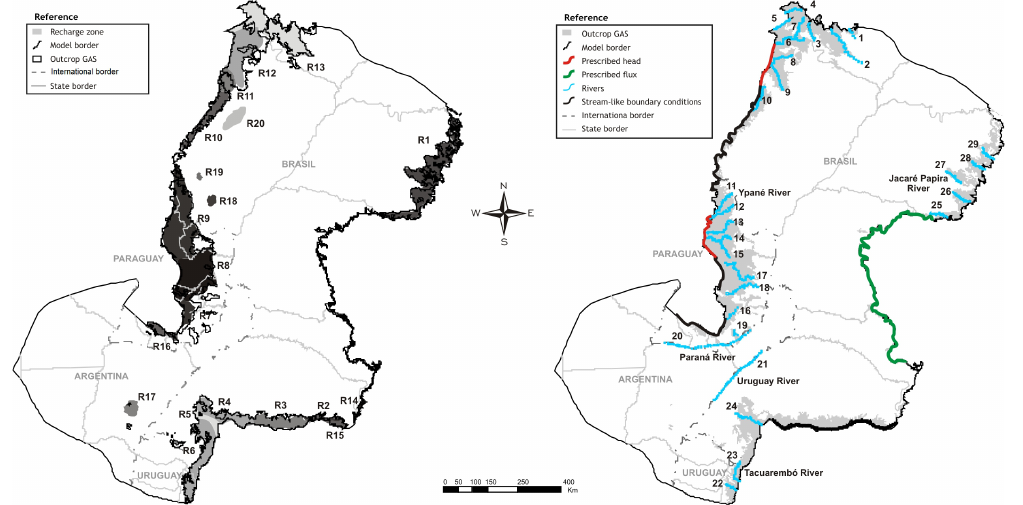
Fig. 4. Simulated boundary conditions, recharge areas and stream reaches (note: only the simulated reach of minor streams and major rivers like the Paran´a and Uruguay rivers, are indicated; the full drainage network is omitted for the sake of